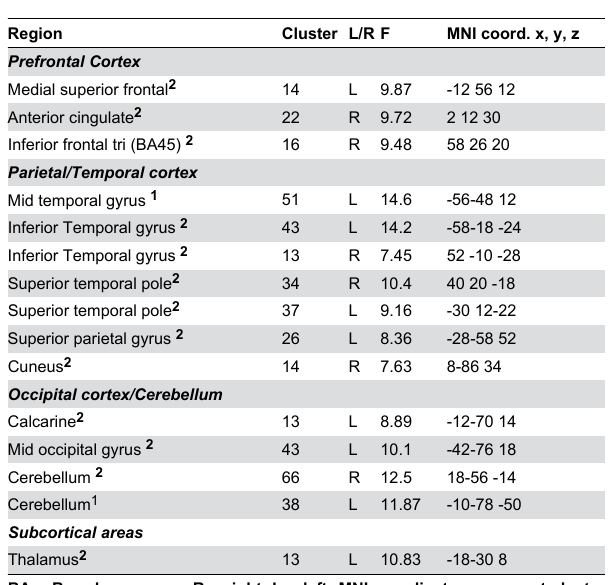
Table 9. Activations resulting from the Ustop> Sstop contrast group comparisons (p <.005, k ≥ 13 voxels). Region Cluster L/R F MNI coord, x, y, z LOW DOSE VS. PLACEBO